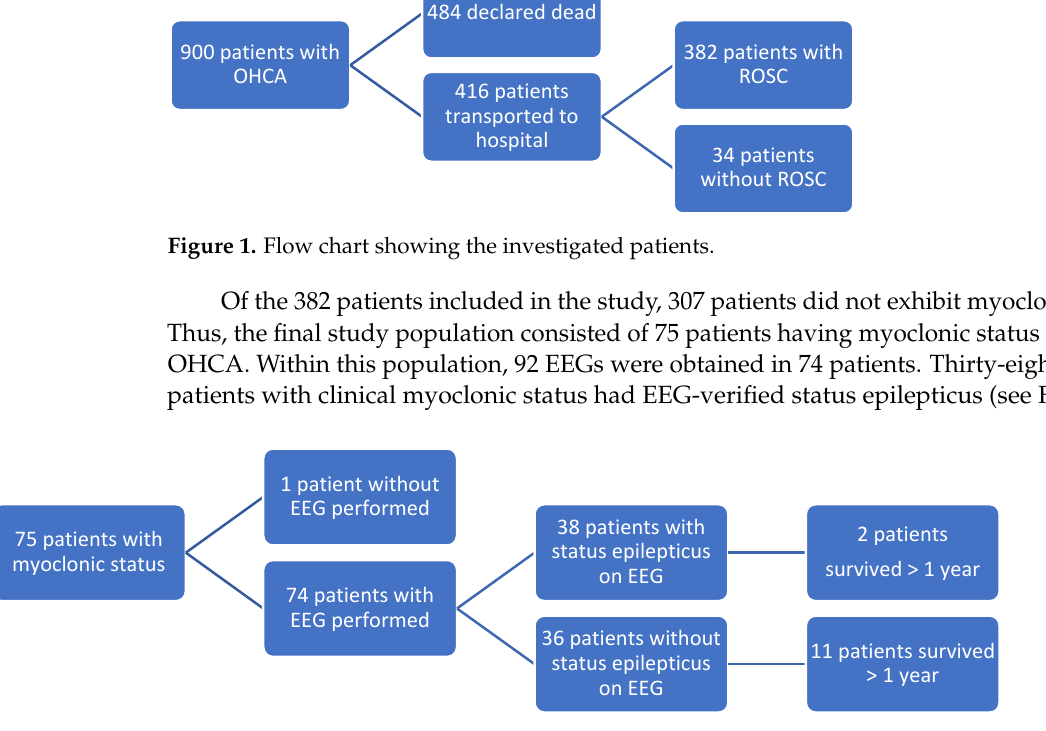
Figure 2. Flow chart showing patients with myoclonic status. There was no association between the occurrence of myoclonic status and sex, age, and time to ROSC. The initial cardiac rhythm, however, differed between the groups of patients with myoclonic status and the group of patients without myoclonic status. Twenty- five of 205 patients (12.2%) with shockable rhythm developed myoclonic status, while 47 of 201 patients (23.4%) with non-shockable rhythm developed myoclonic status. This difference was significant ( p < 0.004). In 10 patients, the initial cardiac rhythm was not recorded (see Table 1 for patient characteristics). Table 1. Characteristics of the patients. (* Values concerning coronary angiography and revasculari- sation of “All patients admitted to hospital with ROSC” are quoted from